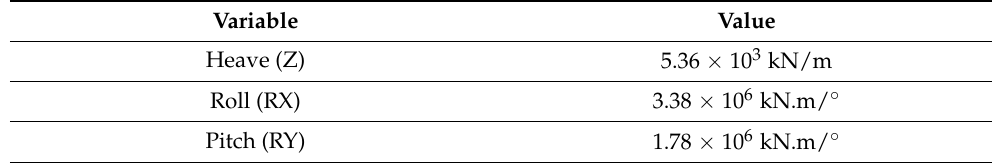
Table 7. Hydrostatic stiffness values of the